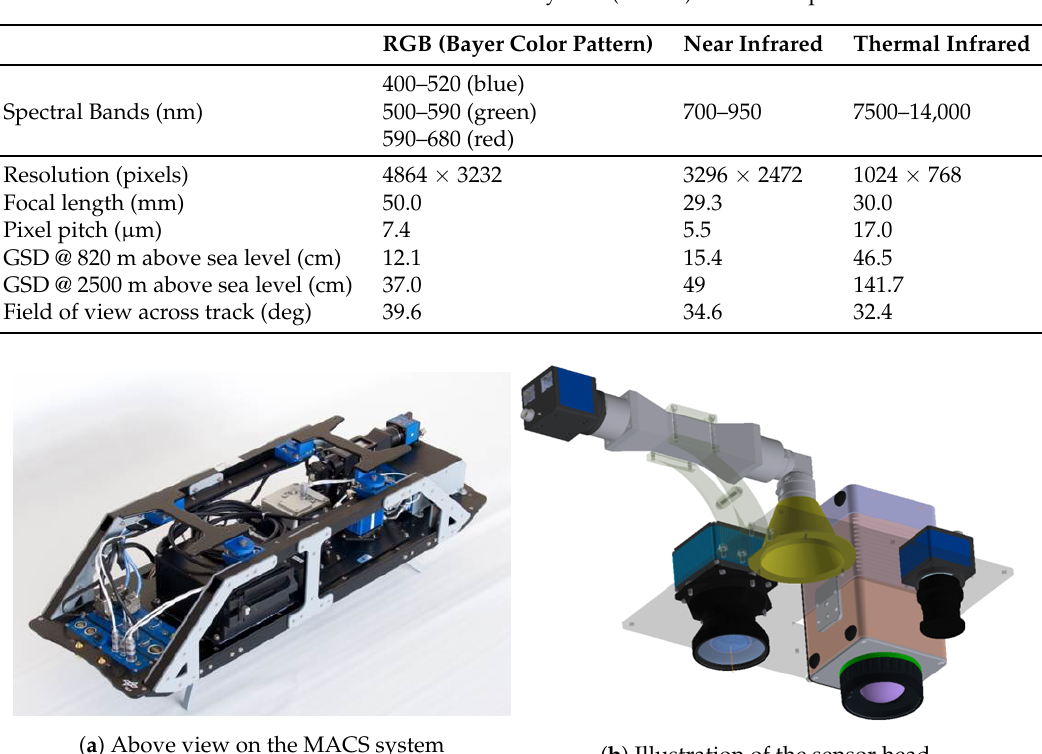
Table 1. Modular Aerial Camera System (MACS) sensor setup.